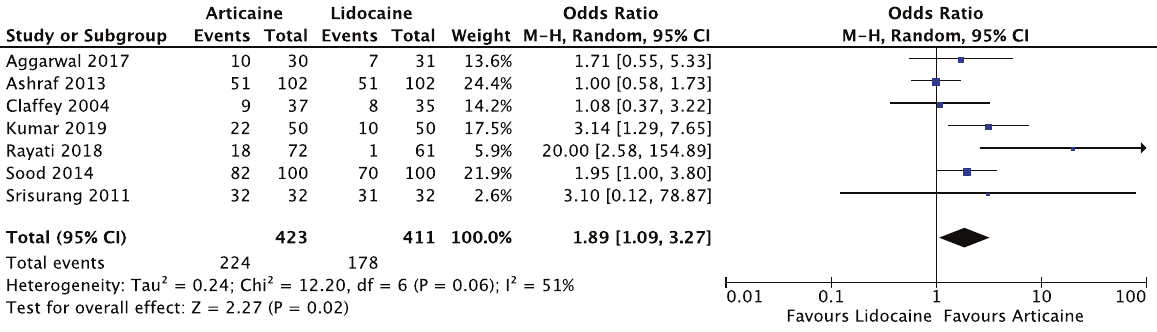
Fig. 11 Forest plot — studies with pre-operative symptomatic teeth. Articaine had 1.89 times likelihood of anaesthetic success of